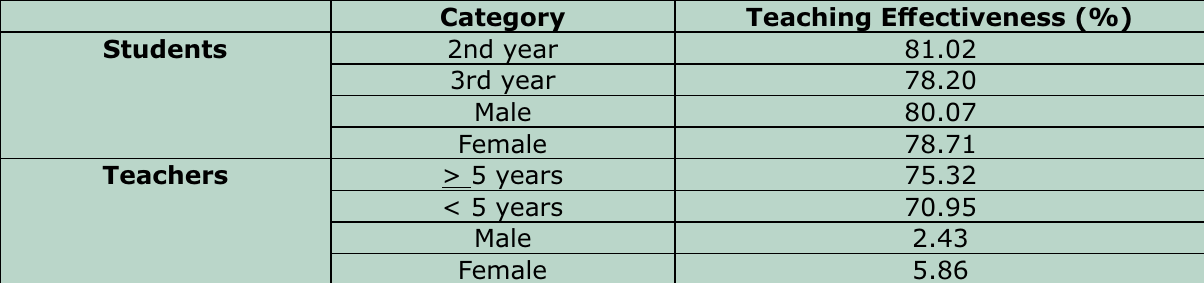
Table-V: Descriptive statistics for students rated score of teaching